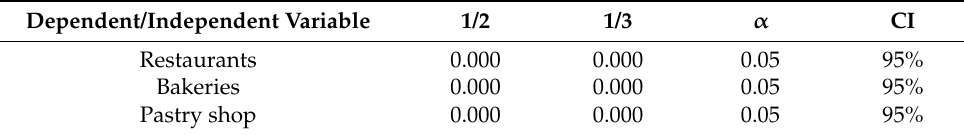
Table 9. Ratio of swab results for all three